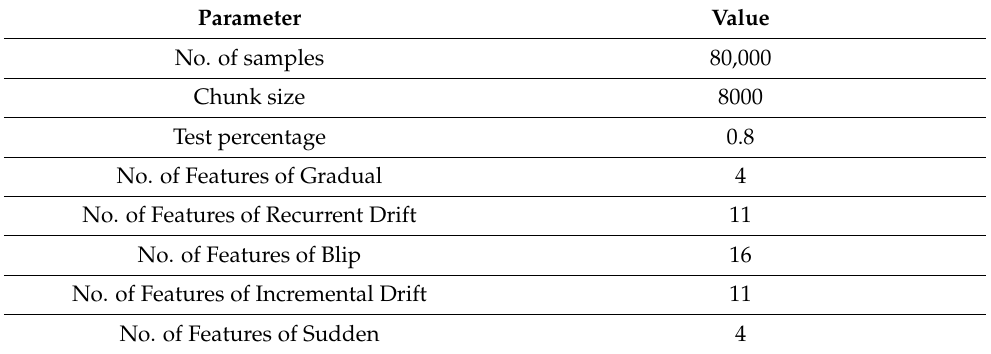
Table 4. Parameters of generating data stream from